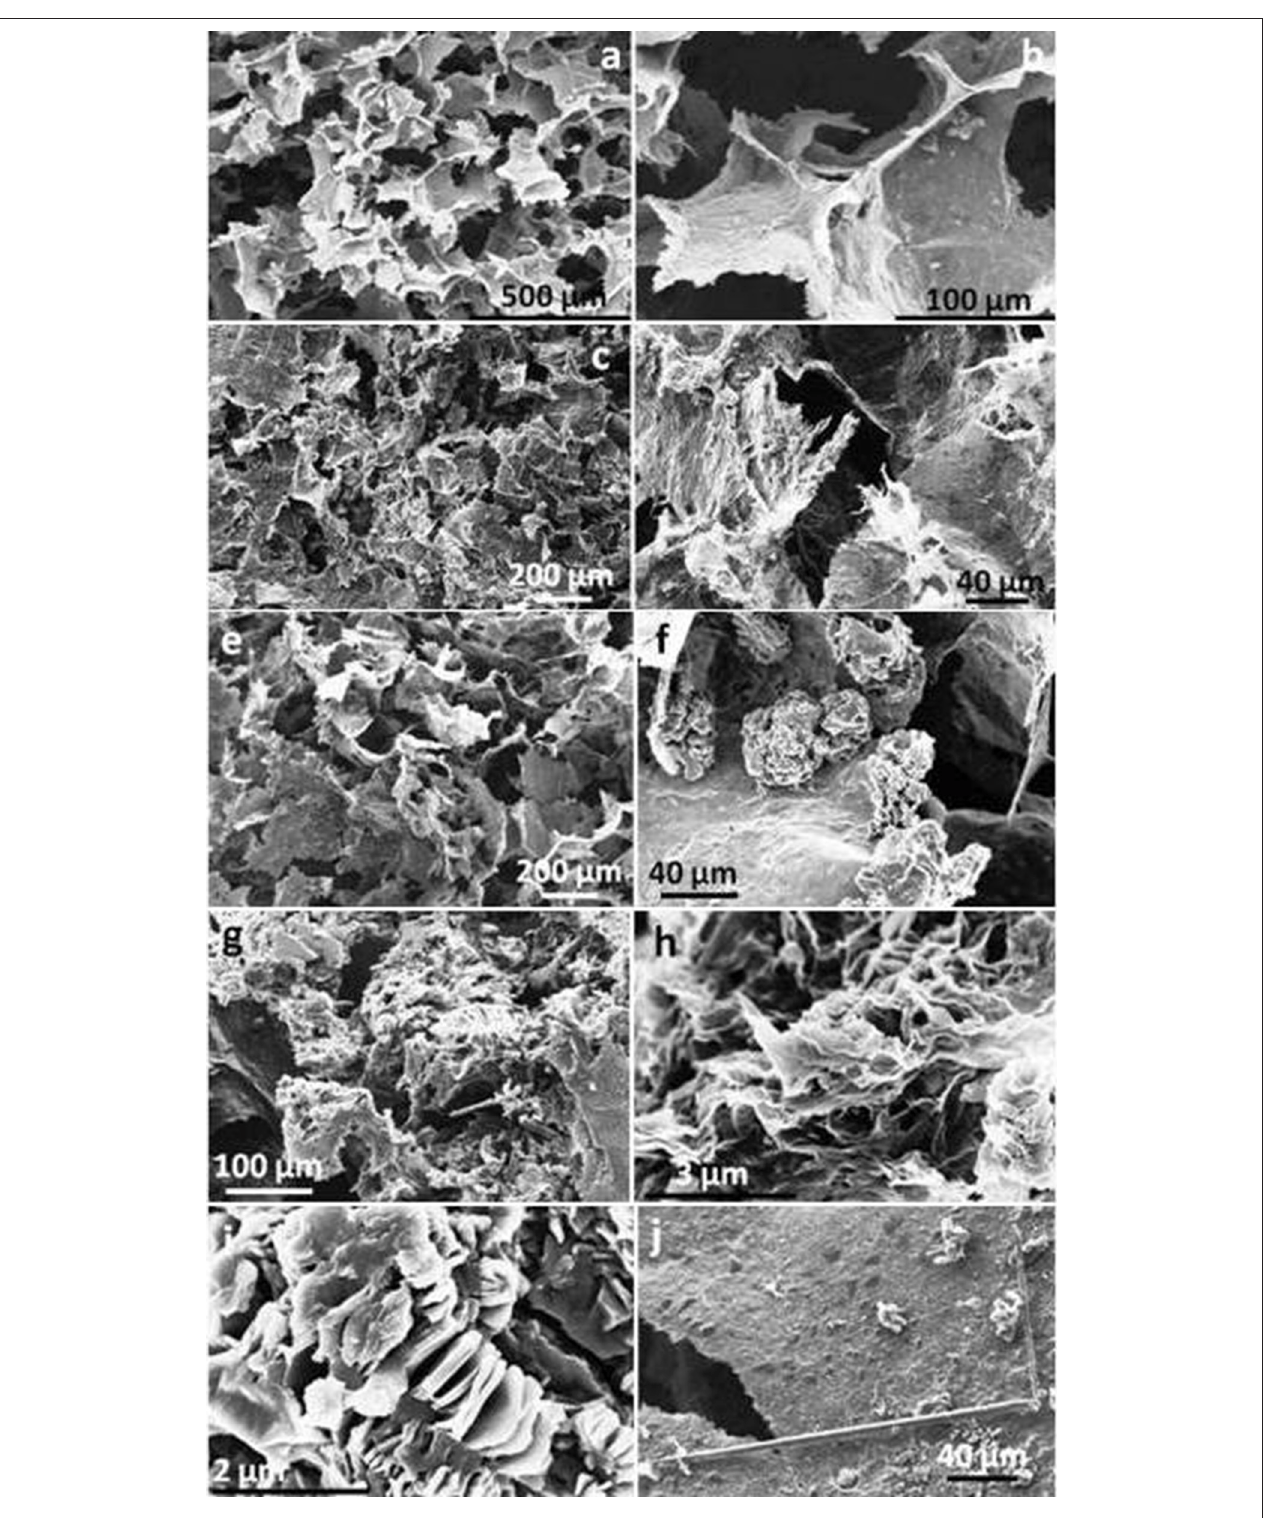
FIGURE 4 | SEM images of (a,b) rGO PPD , (c,d) rGO OPD , (e,f) rGO DAB , and (g,h) rGO MDA aerogels. (i) magnified image of the crystals that are localized on graphene surface in rGO DAB and (J) rGO MDA